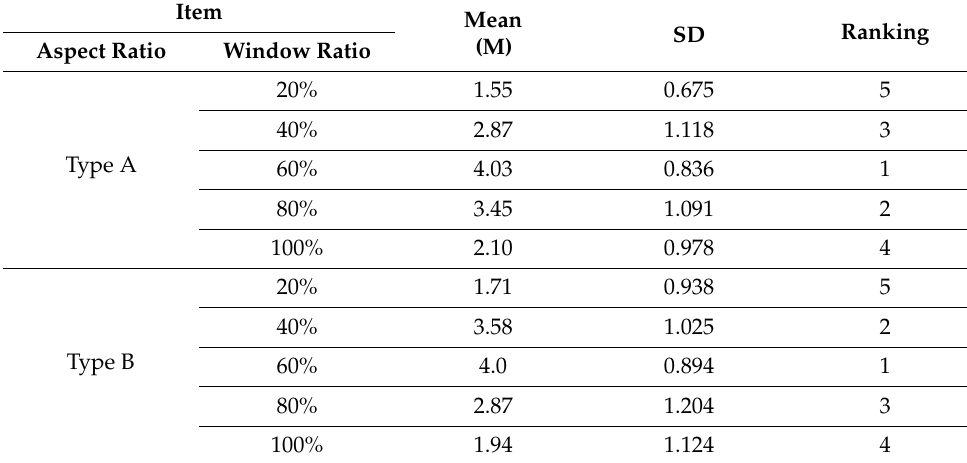
Table 3. Survey on relaxation-arousal consciousness in response to window ratios per aspect ratio of space ( n =